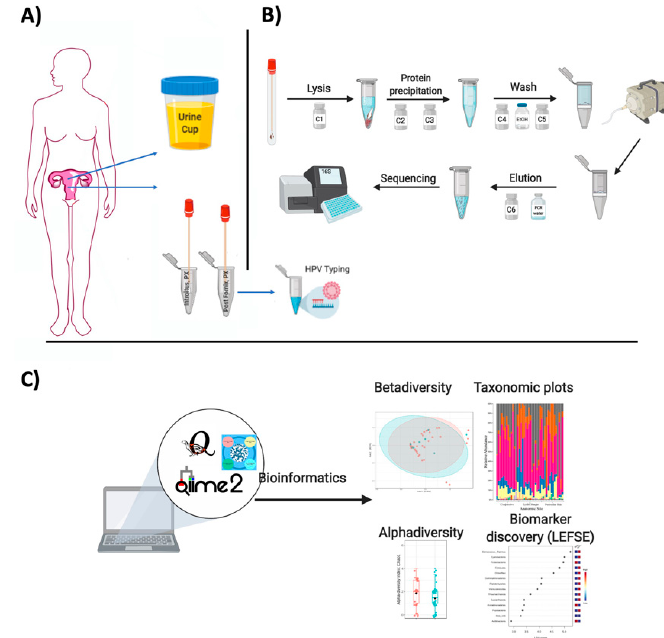
Figure 1. Summary of sample acquisition and analyses. ( A ) shows sample collection in the Ob / Gyn, ( B ) summarizes DNA extraction and ( C ) summarizes data analyses platforms and types of analyses used in microbiota studies.